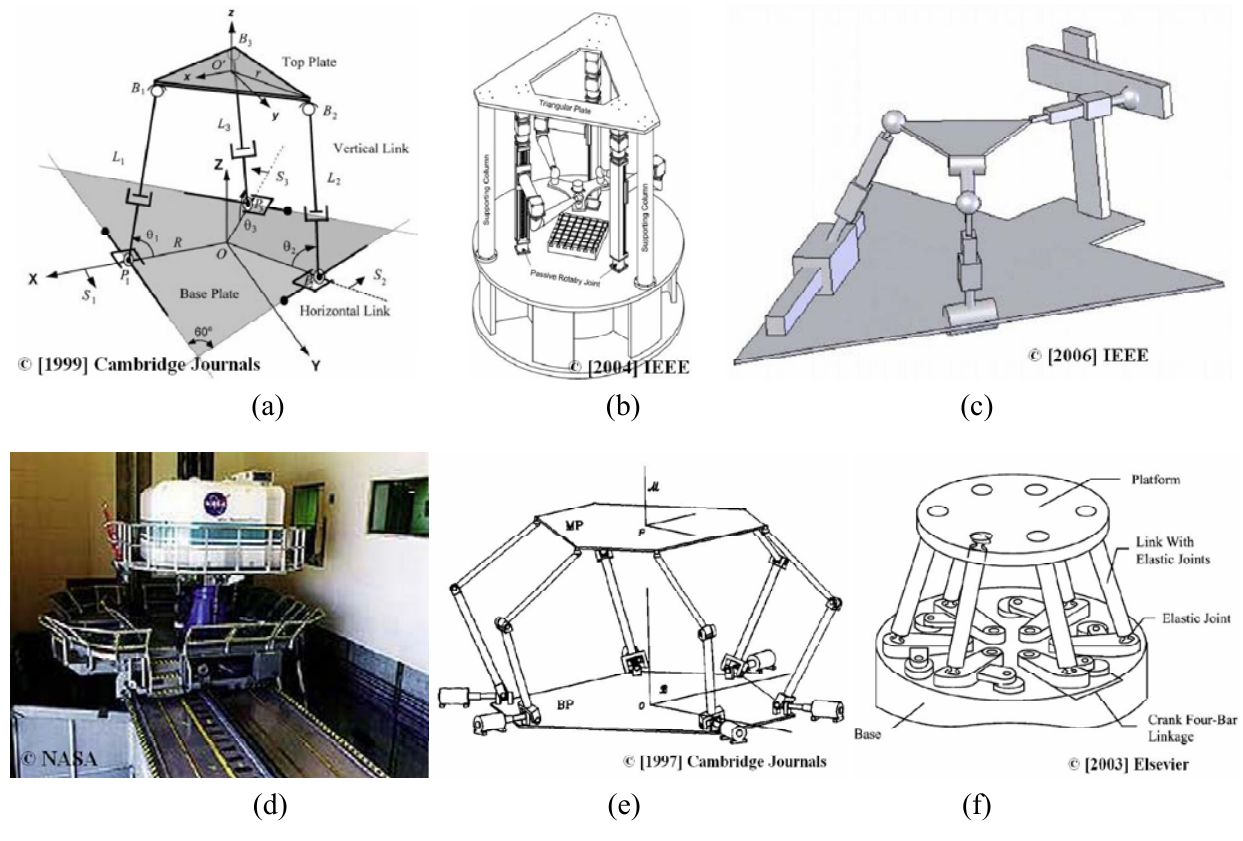
Figure 5. Six-DOF mechanisms: (a) Shim design (reproduced from [34] with permission from Cambridge Journals). (b) Yang design (reprinted from [1] with permission from IEEE). (c) Ben-Horin design (reprinted from [35] with permission from IEEE). (d) VMS (reprinted from [36] with permission from NASA. (e) Zanganeh design (reproduced from [37] with permission from Cambridge Journals). (f) Wang design (reprinted from [38] with permission from